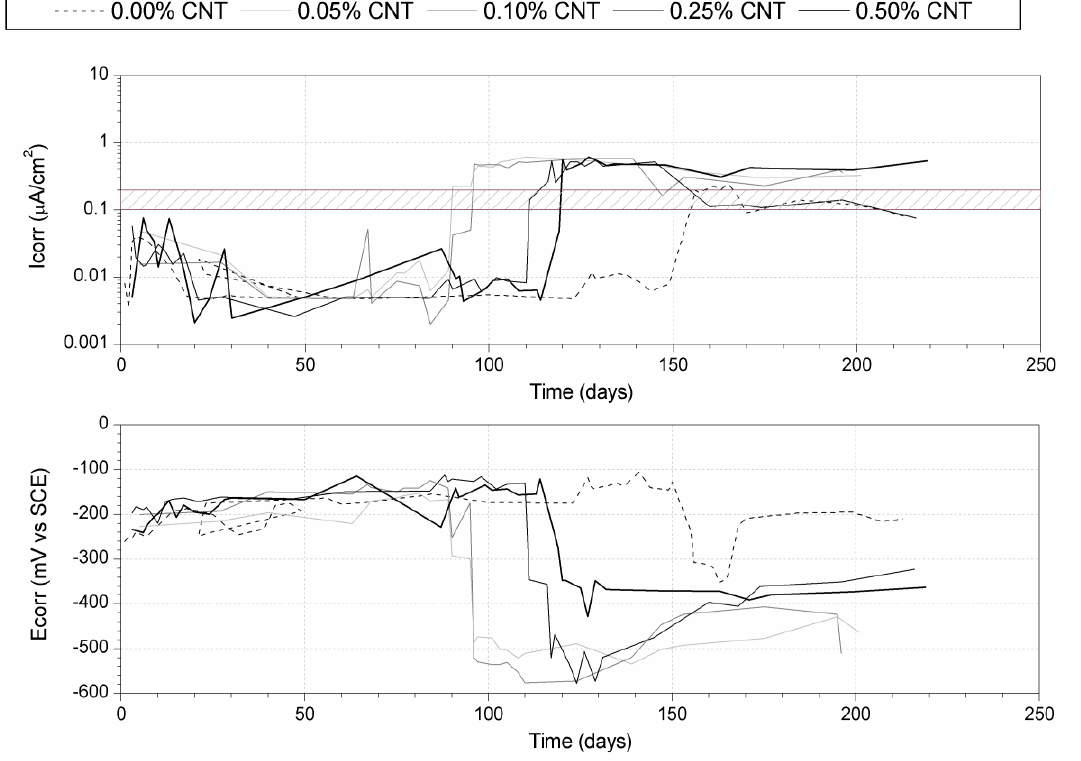
) and corrosion rate ( I ) of steel rebars corr corr